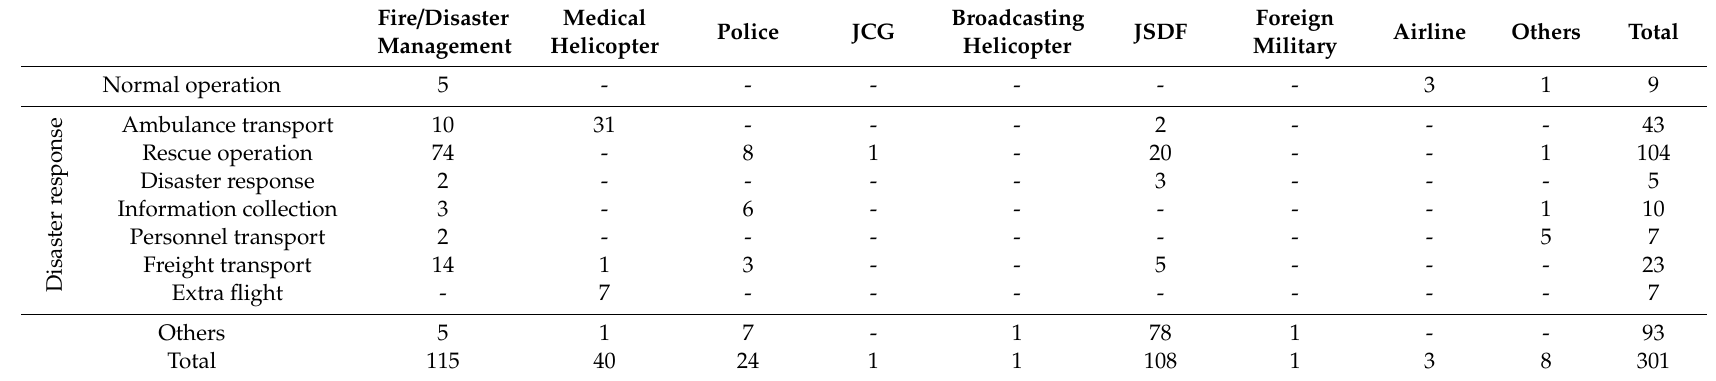
Table 2. Helicopter operators and number of operations by purpose for Hanamaki Airport from 11–14 March, immediately after 2011 Great East Japan Earthquake (Source: Choi and Hanaoka [13], unit: sum of take-o ff s and